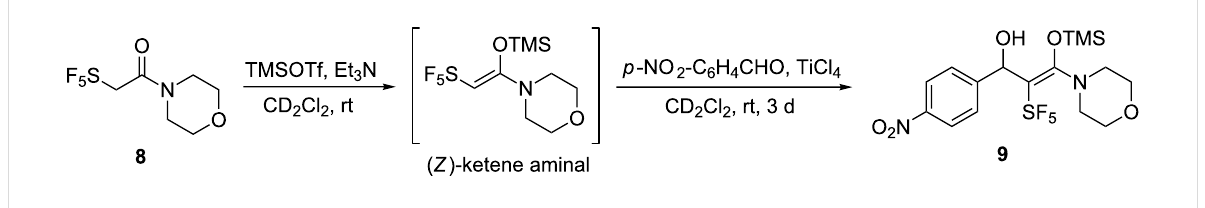
Scheme 6: Intermediate formation of the ( Z )-ketene aminal from morpholide 8 with TMSOTf/ Et 3 N and subsequent transformation to an aldol addition product 9 with p -nitrobenzaldehyde.